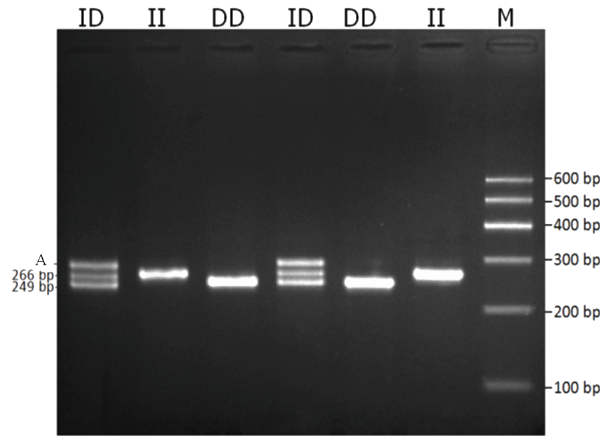
Figure 2. The agarose gel electrophoresis patterns of the 17 bp indel within the SMAD3 gene. PCR products showed three geno- types at this locus where the insertion type (II genotype) consisted of 266bp, deletion types (DD) consisted of 249bp, and the het- erozygote type (ID) showed 266, 249 and 17bp and heteroduplex A fragment, which was detected by 3% agarose gel electrophoresis.